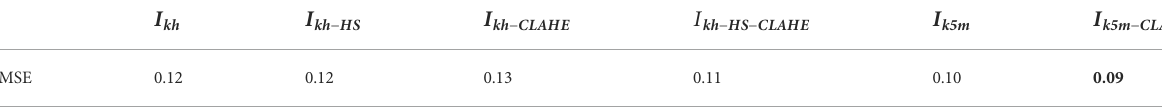
TABLE 4 RMSE of internal and external testing set compared with ground-truth.